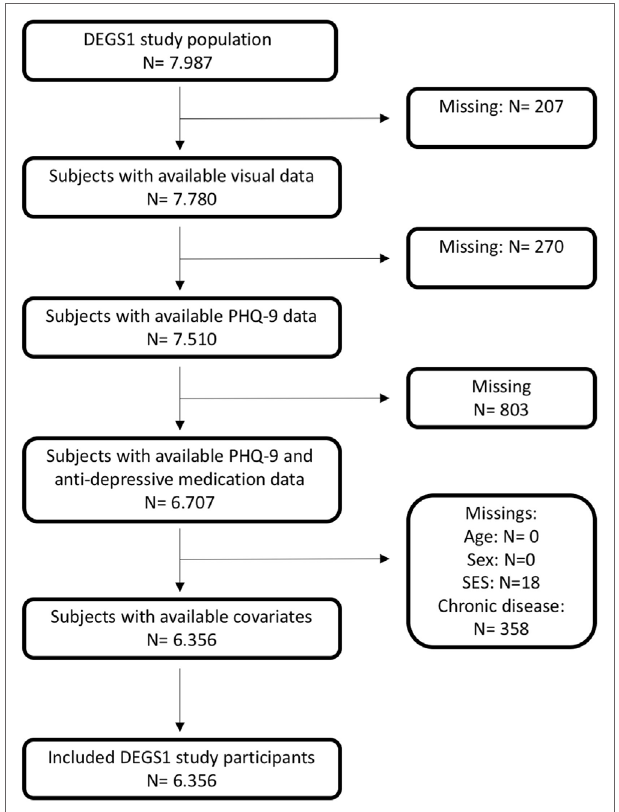
FigUre 1 | Flow chart of data availability in the DEGS1 study cohort with respect to subjective visual impairment and depressive